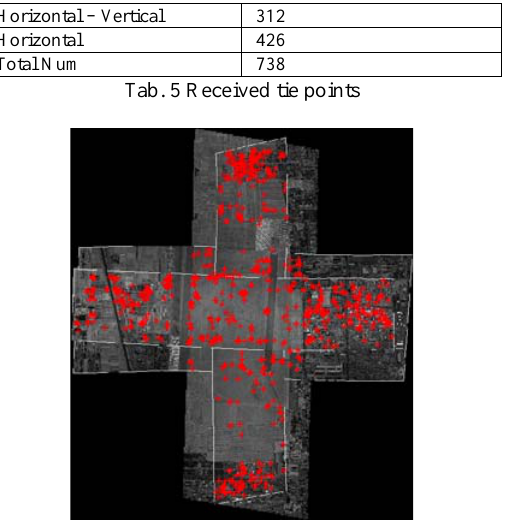
Fig. 4 Distribution of final tie